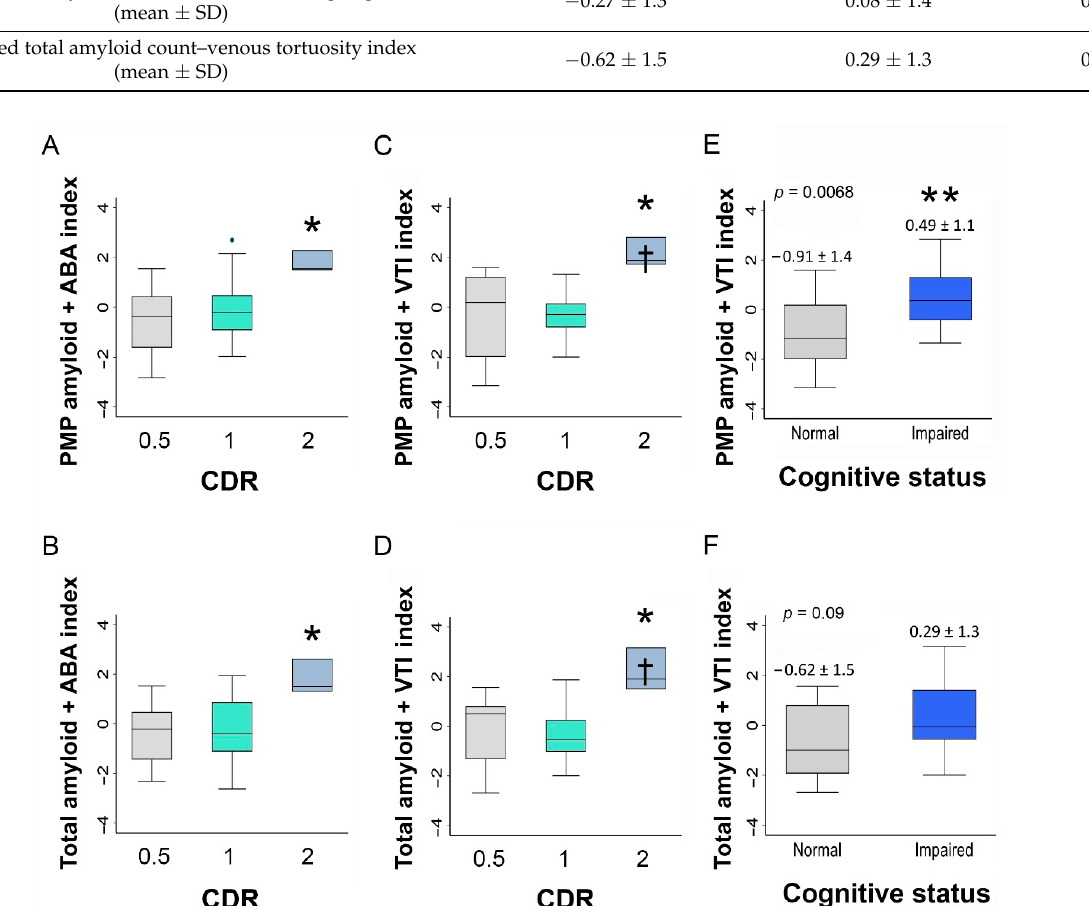
Figure 2. Combined retinal amyloid and vascular parameters in patients stratified by cognitive scores. Graphs illustrating the differences in the combined proximal mid-periphery amyloid-arterial branching angle index ( A ), total amyloid-arterial branching angle index ( B ), proximal mid-periphery amyloid-venous tortuosity index ( C ), and total amyloid-venous tortuosity index ( D ) when stratified by CDR score. Graphs illustrating the differences between the combined proximal mid periphery amyloid-venous tortuosity index ( E ) and total amyloid-venous tortuosity index ( F ) when stratified by the cognitive status. Bar graphs show the mean and deviation (* p < 0.05 and ** p < 0.01 by two-tailed paired Student’s t -test). Abbreviations: VTI, vessel tortuosity index; ABA, arterial branching angle; PMP, proximal mid-periphery; and CDR, Clin- ical Dementia Rating.